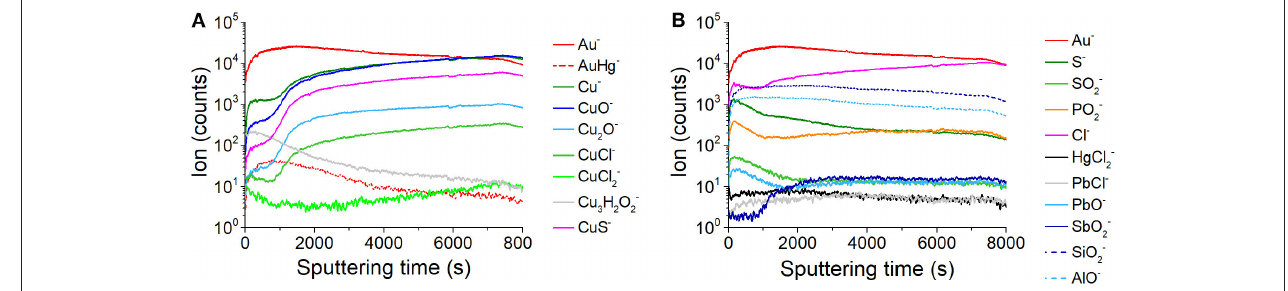
FIGURE 4 | Depth profiles for selected ions revealed during the analysis: (A) ion signals characteristic of the artifact and corrosion patina constituents; (B) ion signals related to other corrosion products and materials from the external environment.